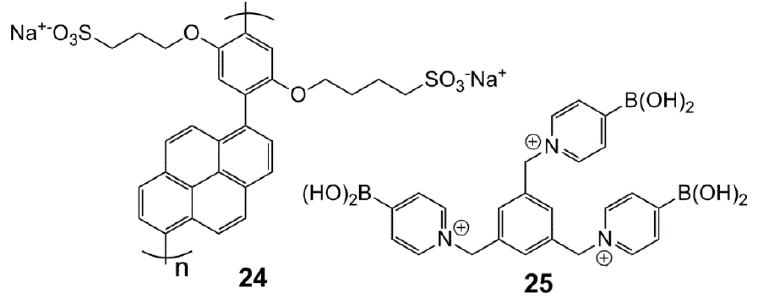
Figure 10. Poly(p-phenylene-pyrene)-sulfonate, 24 , and tris(pyridiniumboronic acid), 25 [73].